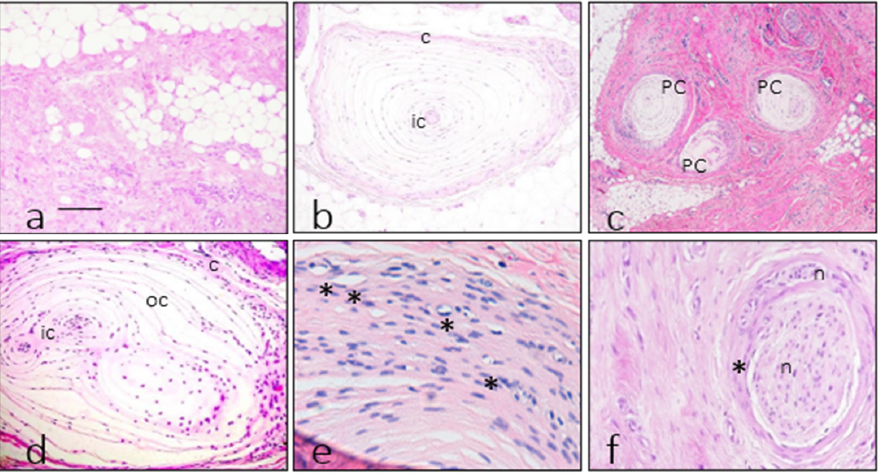
Figure 1. Morphology found in the fibromatosis and control cases. The fibromatosis case had a fibrous proliferation apparent in the subcutaneous tissue with low cellularity but the presence of infiltrative tracts in the hypodermal adipose tissue ( a ). Control Pacinian corpuscles ( b ) had a thin capsule (c), making contrast with the peripheral fatty tissue and also had a more colored inner core (ic) with a solid central structure with no nuclei consistent with an axon. The neoplastic fibrous proliferation encompassed some Pacinian corpuscles (pc), with a clustered appearance at low power ( c ). Corpuscles from the fibromatosis case ( d ) didn’t displayed the solid inner core/axon complex, and in the central region corresponding with the inner core area (ic) it was often apparent capillaries. The capsule of various corpuscles from the fibromatosis case ( e ) displayed a thickened capsule with an abundance of small blood vessels (*). Peripheral nerves ( f ) found inside the neoplastic fibrous proliferation showed intense fibrosis (*) entrapping nerve fascicles (n). Images ( e , f ) demonstrate the perineurial nature of the nerve fibers fibrosis employing consecutive slides showing a thick CD34 negative layer surrounding the nerve fiber ( e ) and the same thick layer positive for Glut1 ( f ). Scale bar correspond to 50 μ m in images ( a , b , d ), 100 μ m in ( c ), 20 μ m in ( e ), and 30 μ m in ( f ).